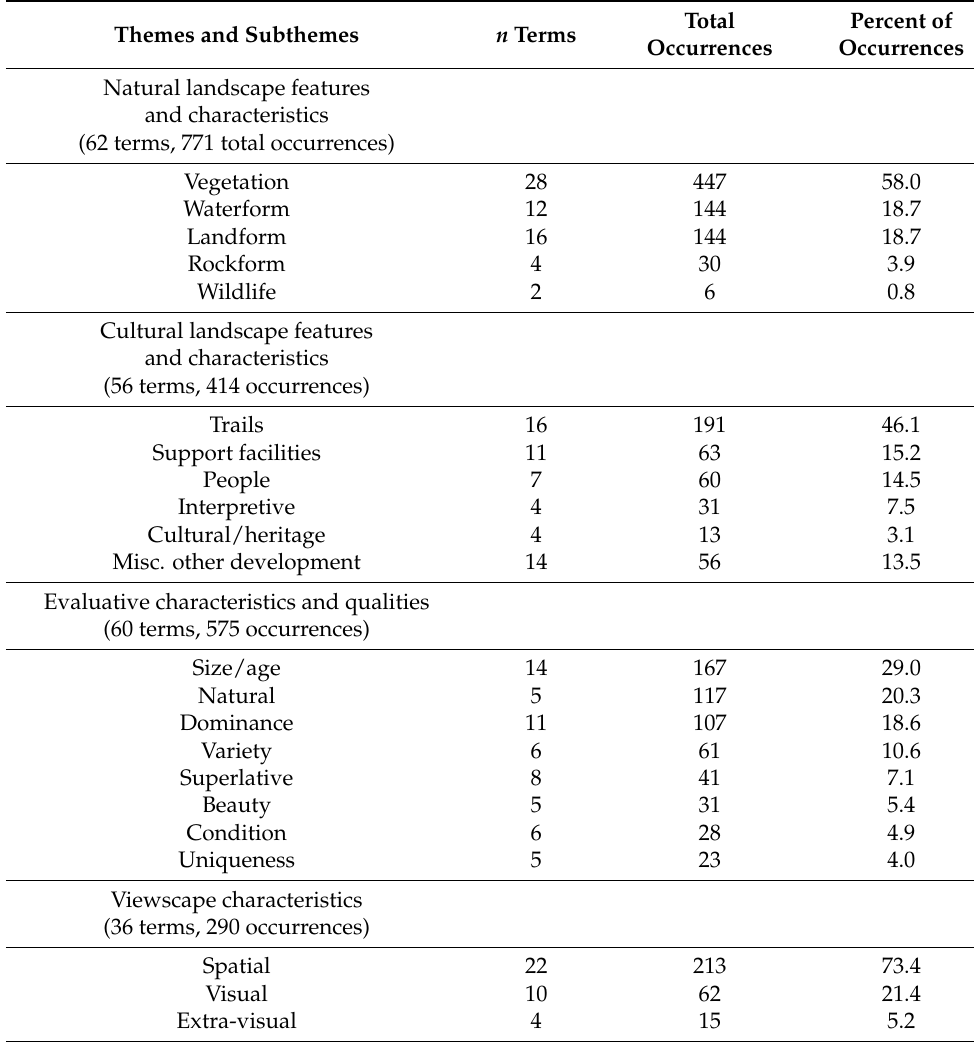
Table 5. Relevant themes and subthemes of key features and characteristics extracted from a lexico- metric analysis of forest setting descriptions in the article